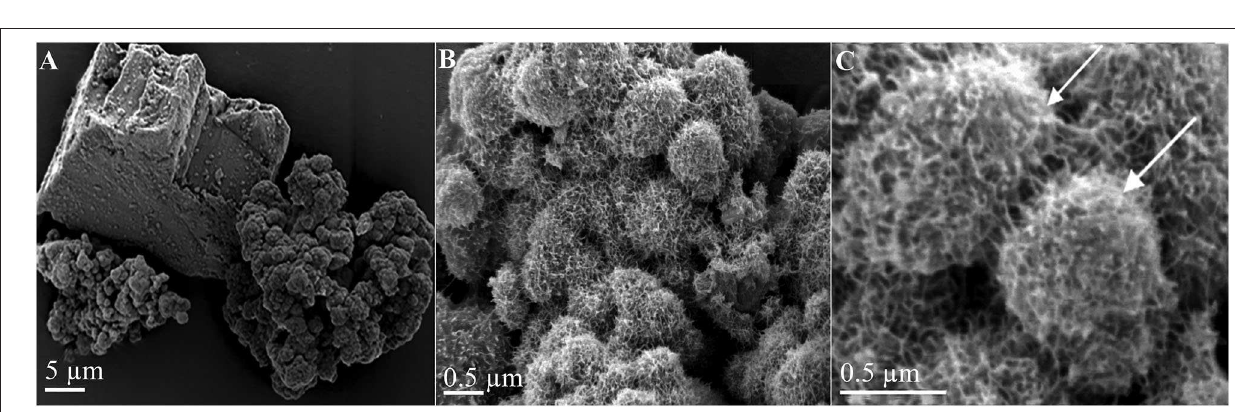
FIGURE 3 | Scanning electron microscopy images of M. sedula supplemented with the stony meteorite NWA 1172 as the sole energy source at cold temperature regime . (A) Scanning electron image, showing an angular mineral fragment of NWA 1172 clustered by M. sedula aggregated cells at the cold temperature regime. (B,C) Higher magnification scanning electron images displaying single cells of M. sedula covered with extracellular matrix. Cells of M. sedula are indicated with white arrows. Cultures of M. sedula were examined with SEM after 2 months of cultivation at the average temperature of 12 ◦